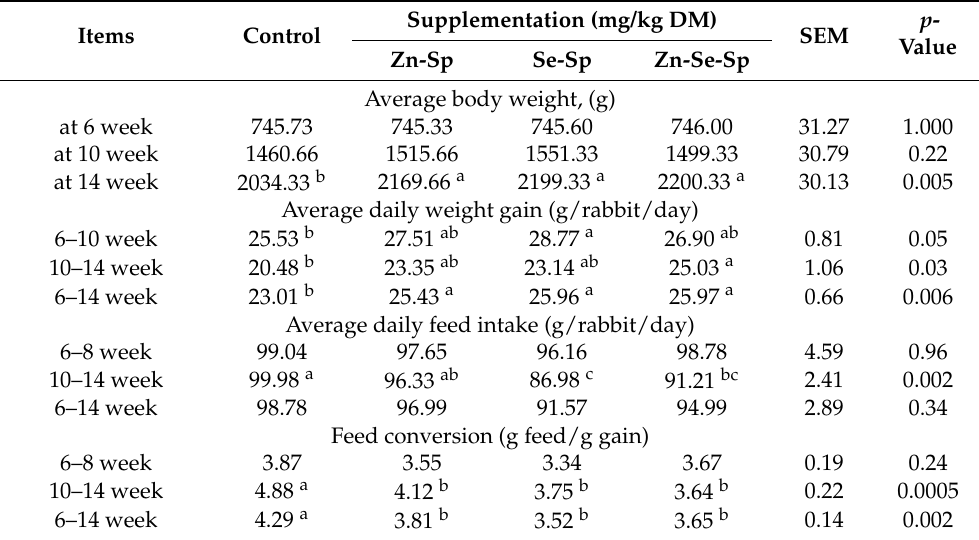
Table 2. Effect of dietary Zn-Sp, Se-Sp and their combination on the growth performance of growing rabbits.